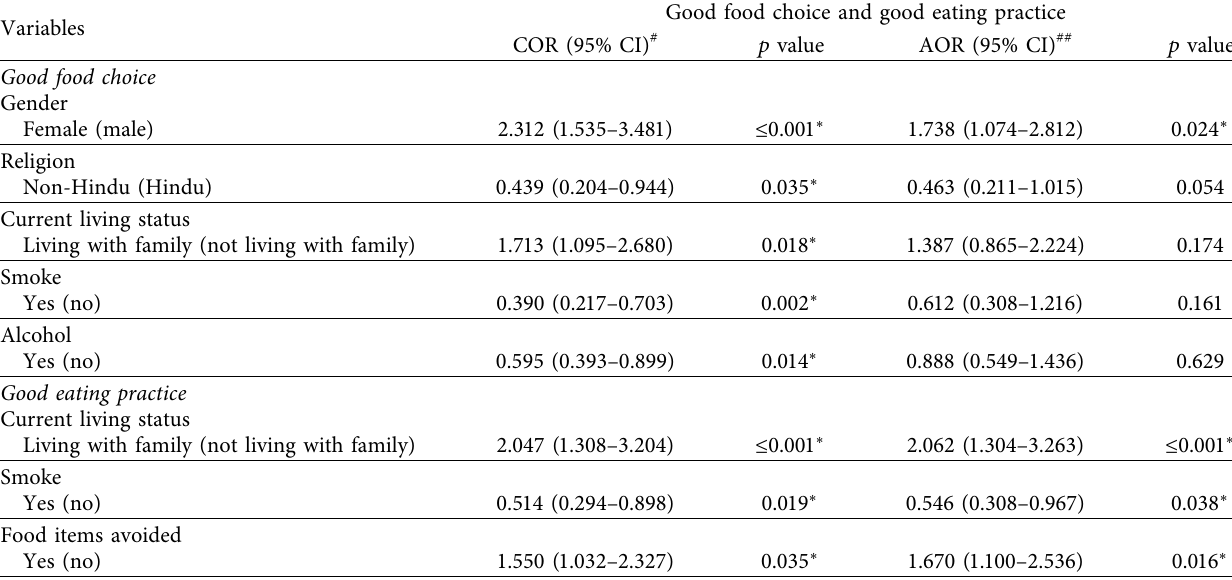
Table 5: Logistic regression for food choice and eating